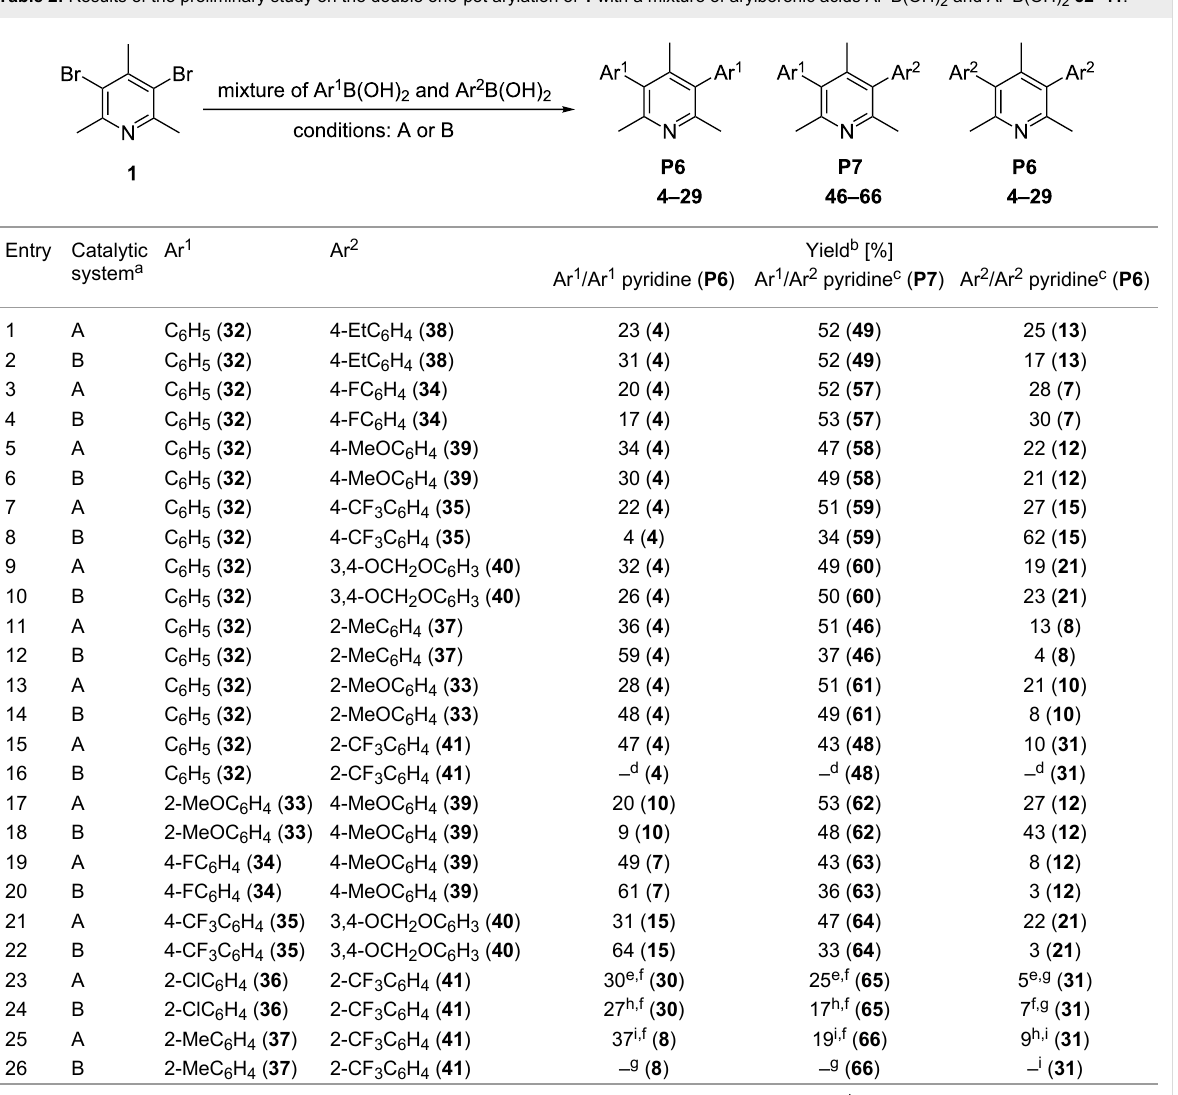
Table 2: Results of the preliminary study on the double one-pot arylation of 1 with a mixture of arylboronic acids Ar 1 B(OH) 2 and Ar 2 B(OH) 2 32–41 .